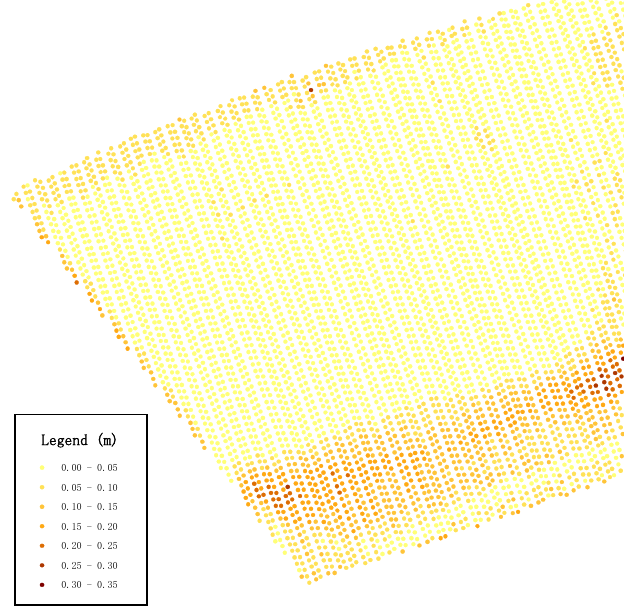
Figure 6. Residuals of overlap zone-1 after registration.